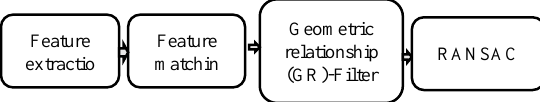
Figure 2. Proposed image processing pipeline.